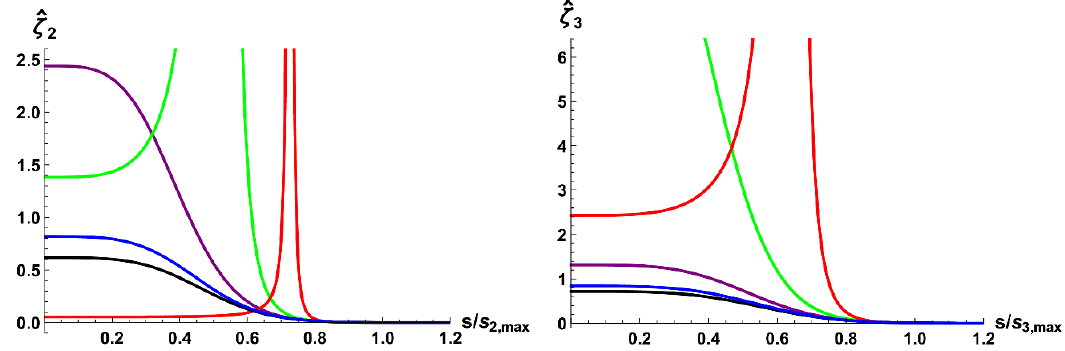
Figure 12 . Reduced bulk viscosity ^ (cid:16) (cid:1) (left panel: (cid:1) = 2; right panel: (cid:1) = 3) of the holographic viscoelastic media to leading order in the explicit Z 2 symmetry breaking (see (5.10) for parametriza- tion). Color coding corresponds to di(cid:11)erent values of the ratio of temperature T to the chemical potential (cid:22) : T = 1 (red), T = 1 (green), T = 1 (magenta) and T = 2 (blue). The former two (cid:22) 12 (cid:22) 6 (cid:22) 3 (cid:22) 3 values are below the critical values of T=(cid:22) j crit at s = 0, and the latter two are above for (cid:1) = 2. For (cid:1) = 3 model only the red curve corresponds to T below the critical value. Black curves correspond (cid:22) to neutral viscoelastic media, i.e., (cid:22) = 0.